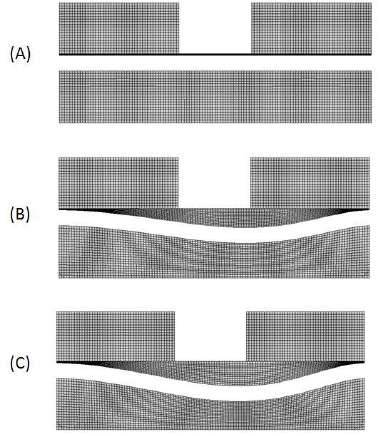
Figure 5. Initial and deformed stages of microvalve mesh in A-A’ cross-sectional plane: ( A ) Initial state of the microvalve. ( B , C ) Microvalve membrane deflected against pressure developed by fluid flow in the source